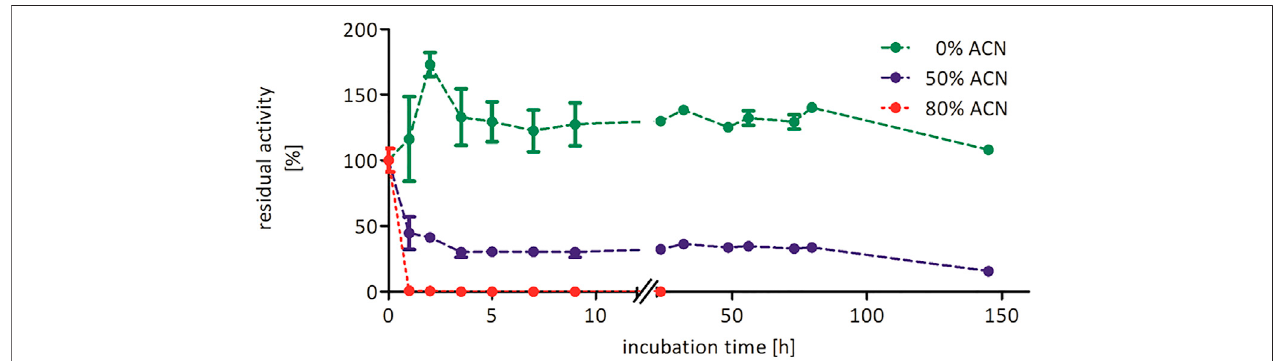
FIGURE 4 | Stability of r Aae UPO (concentrated supernatant) in the presence of 0 vol% (green), 50 vol% (blue), or 80 vol% (red) acetonitrile. Enzyme (1 µM) was incubated in 100 mM KPi, pH 6.0, and indicated acetonitrile concentrations at 25 ° C and 600 rpm in glass vials with 10 mL starting volume. At indicated time points, a 200 µL aliquot was transferred to an Eppendorf tube, and enzyme activity was evaluated via ABTS assay. Data are normalized to the 0 h sample, which was taken immediately after mixing (t 0 = 27.3 U/mL).